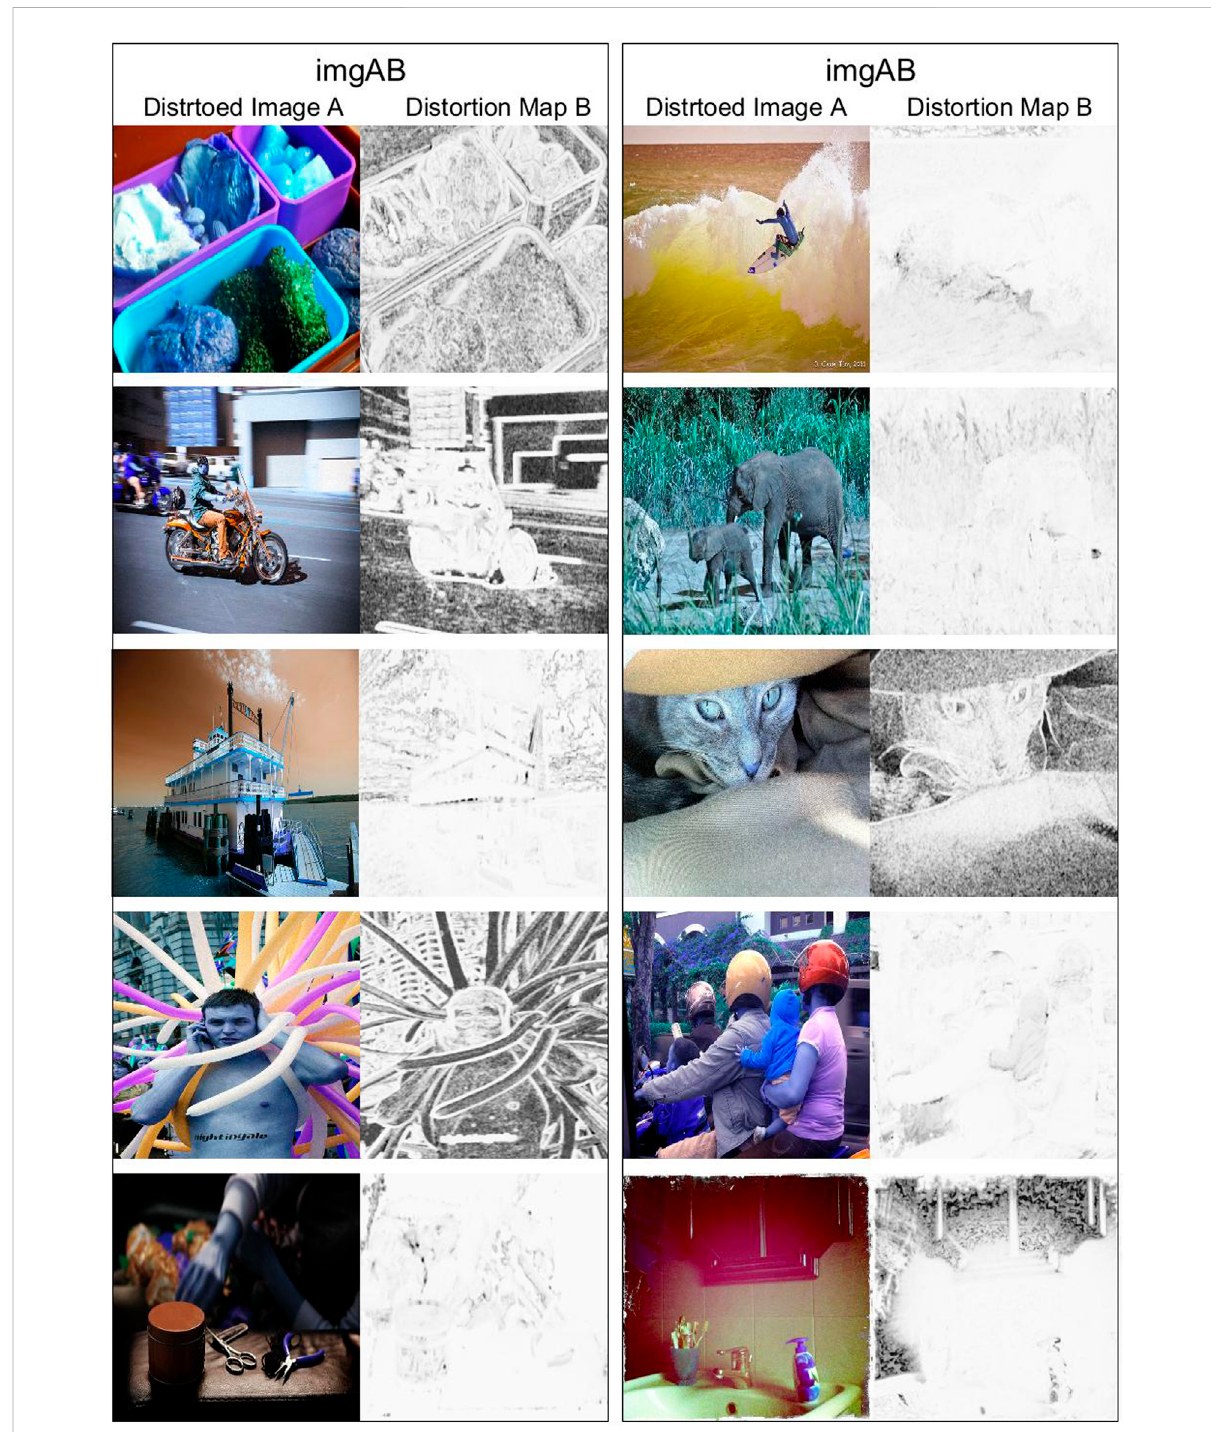
FIGURE 4 Random input samples from cocstuffv2 dataset. Distorted image A is obtained by Albumentation library of augmentations, where Distortion Map B is obtained by SSIM index